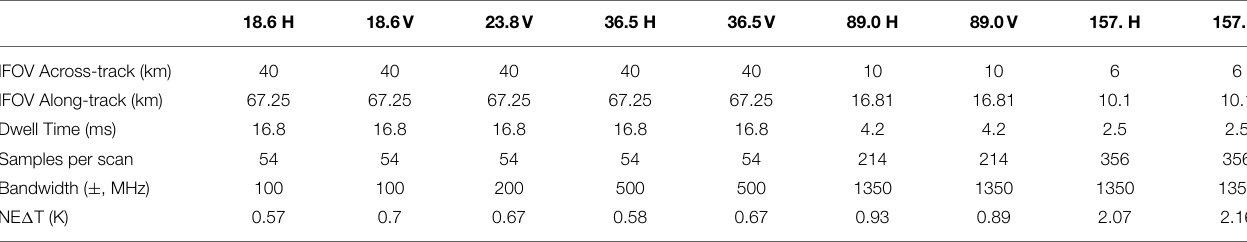
TABLE 1 | Characteristics of MADRAS.